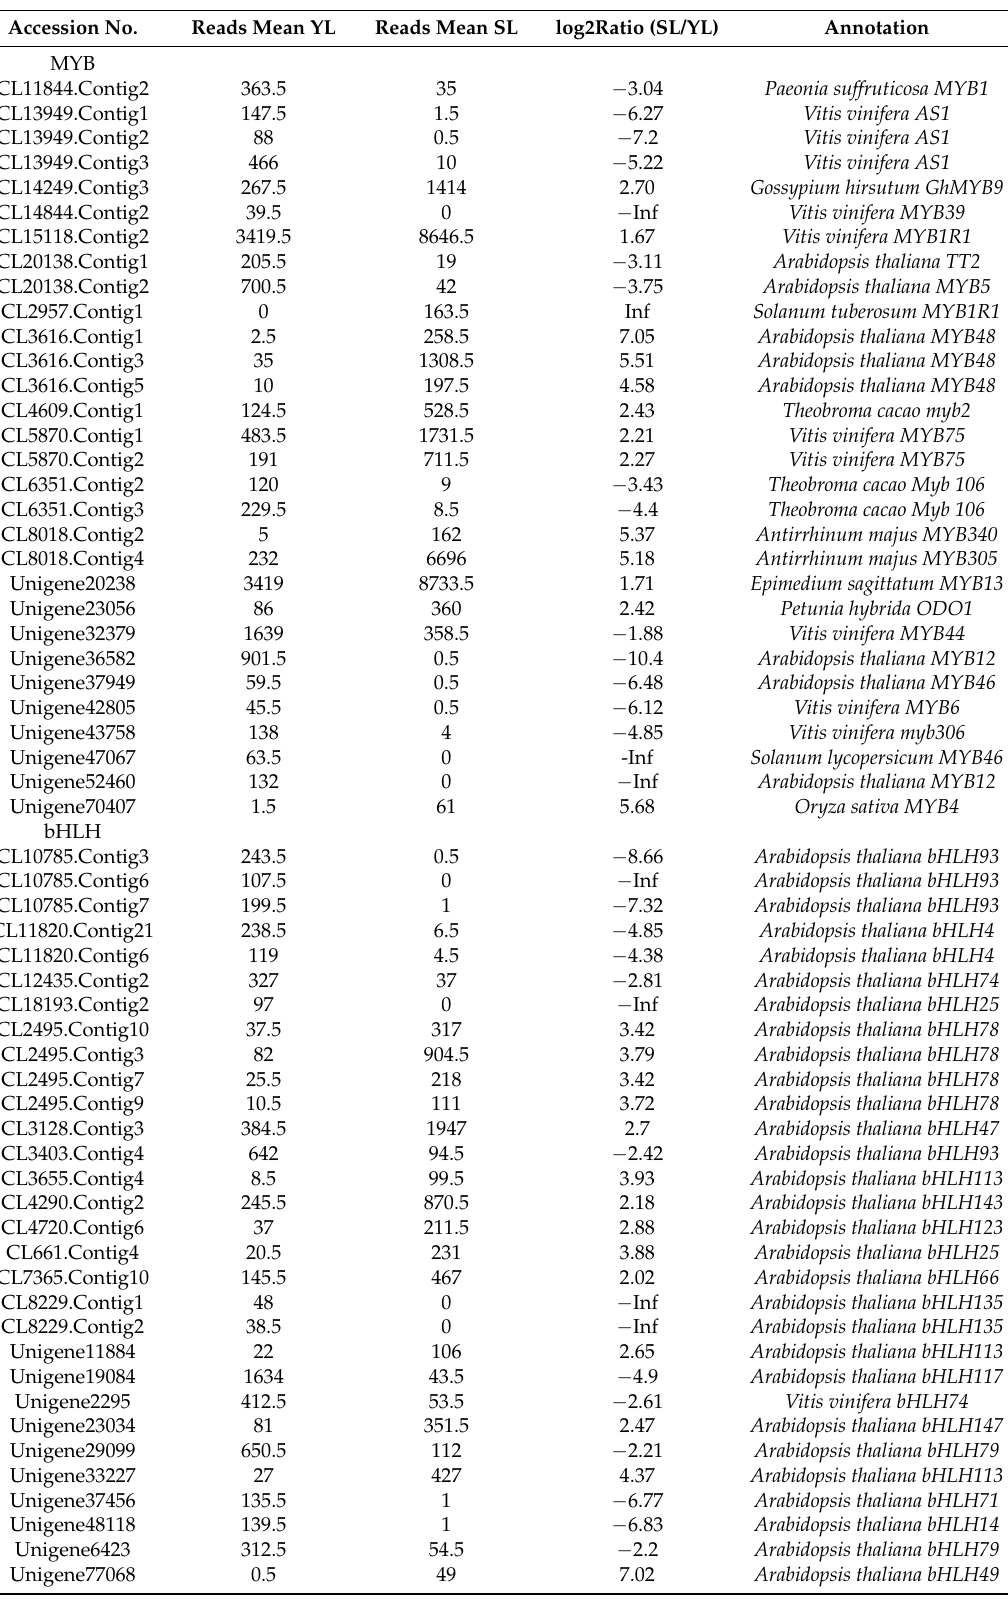
Table 3. DEGs involved in MYB and bHLH family during leaf